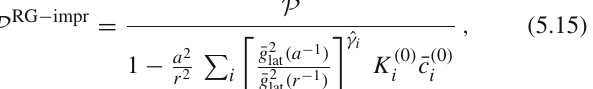
= 1. On the right, we drop the overall naive power of a 2 / r 2 1